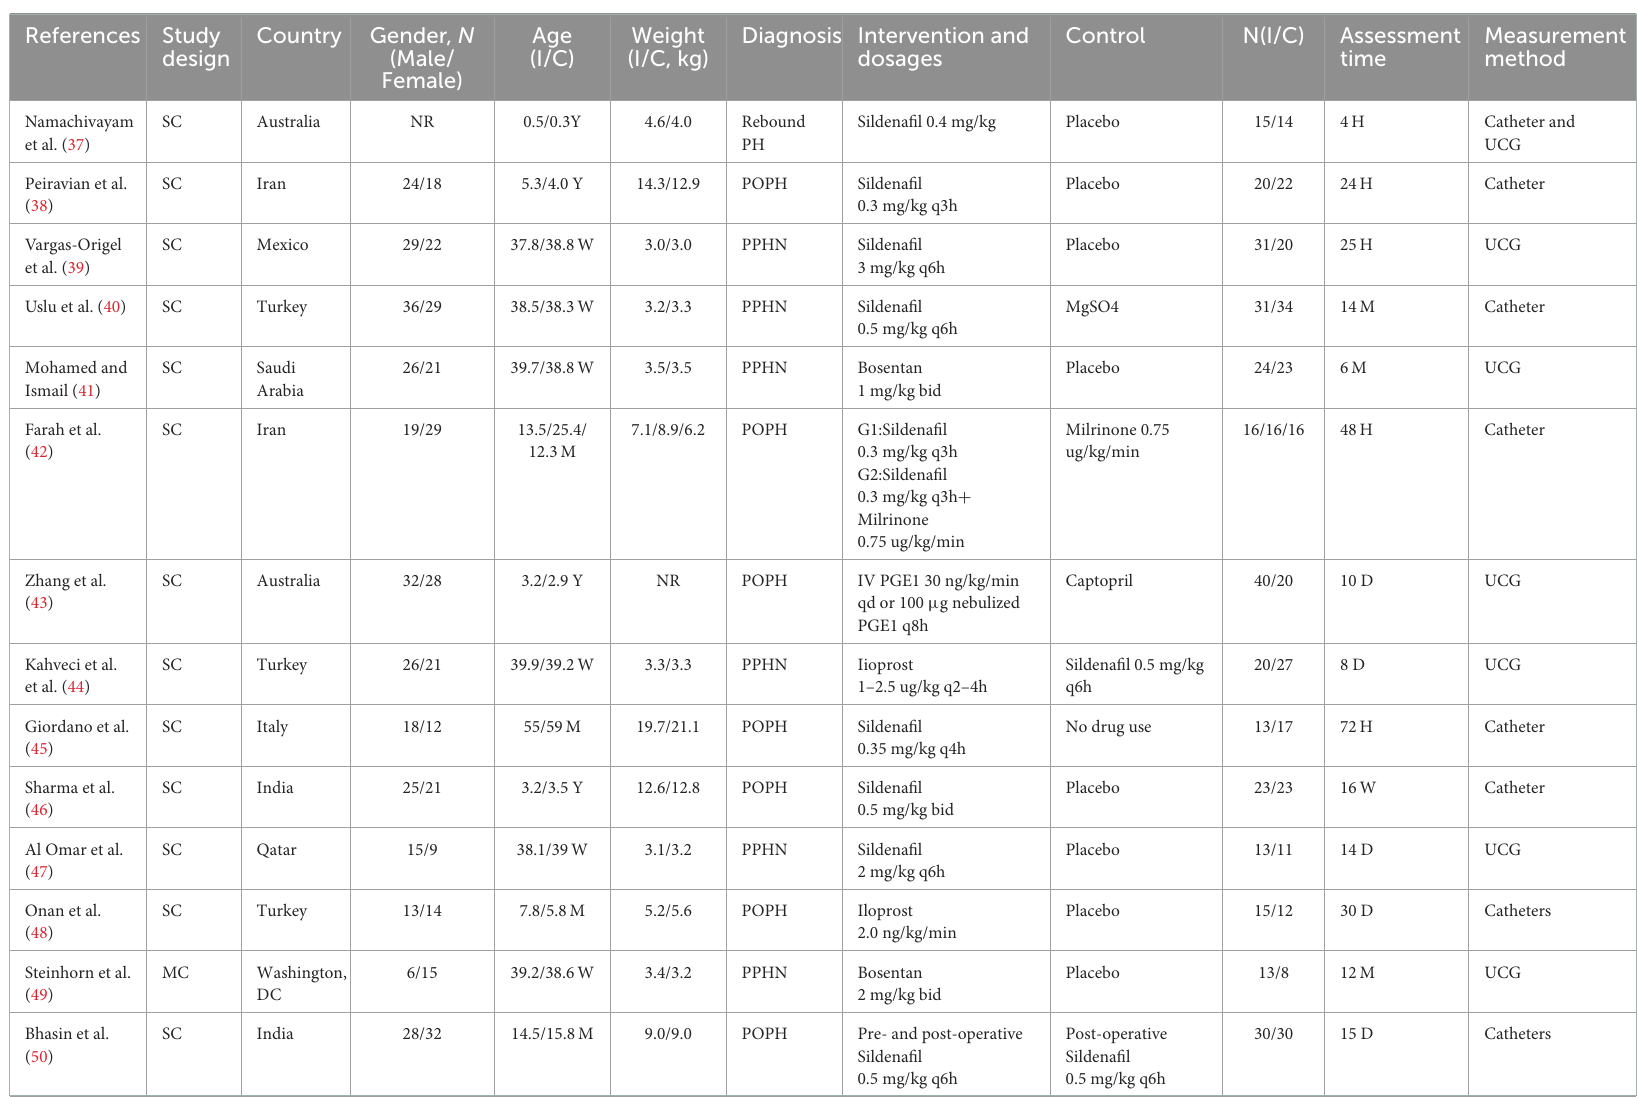
TABLE 1 Basic characteristics of the included